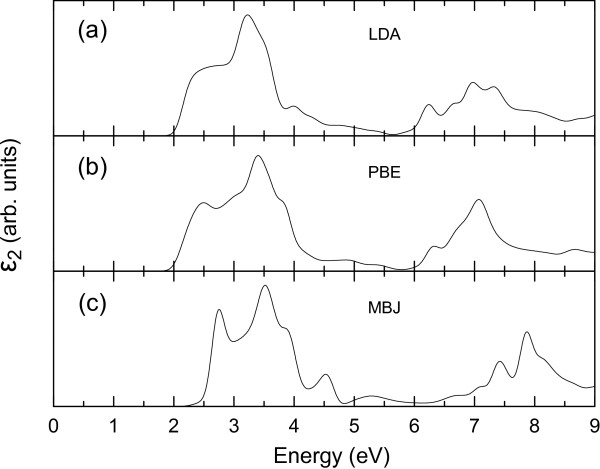
The optical absorption expressed by the imaginary part of the dielectric tensorε2forα-g-B3N3C. The imaginary part of the dielectric tensor is averaged for four different directions. Three XC potentials including (a) LDA, (b) PBE, and (c) MBJ are shown in the calculations.